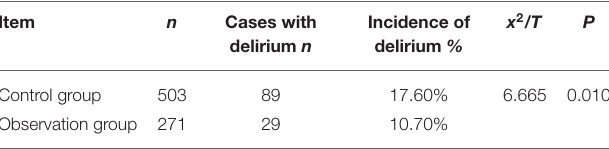
TABLE 2 | The incidence of delirium between the control group and “WeChat” group ( n = 774). Item